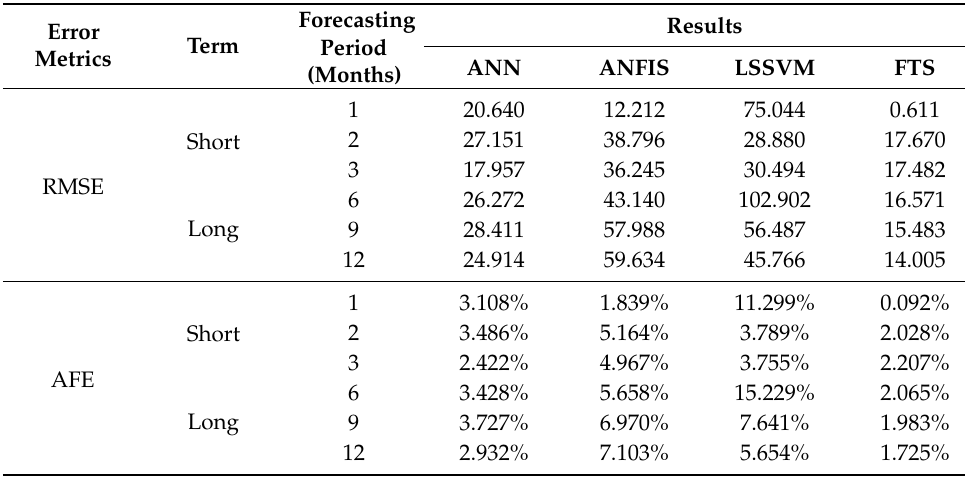
Table 11. Short-term and long-term forecasting results for